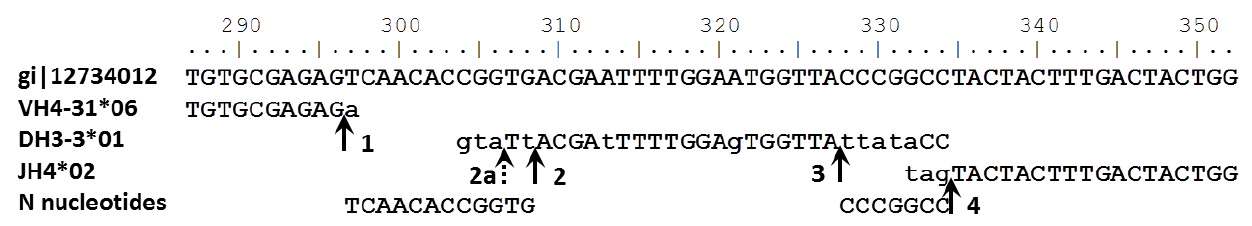
Figure 1. Illustration of parameters for the rearrangement model. Labelled vertical arrows indicate the positions of the recombination sites: 1) RV = 1; 2) RD1 = 5; 3) RD2 = 7; 4) RJ = 3. The dashed arrow 2a indicates a possible alternative recombination site: RD1 = 3. Lower- case letters in the gene-segment sequences indicate mismatches between the observed sequence and the gene segment. The last line shows N nucleotide sequences consistent with the observed and provides a guide applicable to both heavy and light-chain rearrangements.